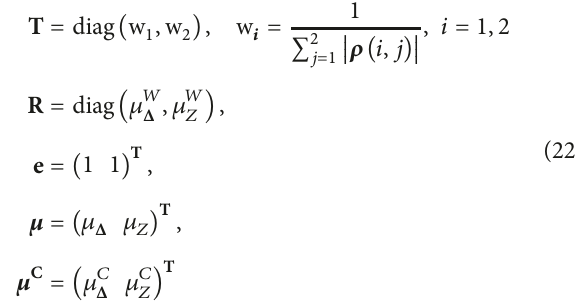
Figure 1: The IMP convex model with a two-dimensional